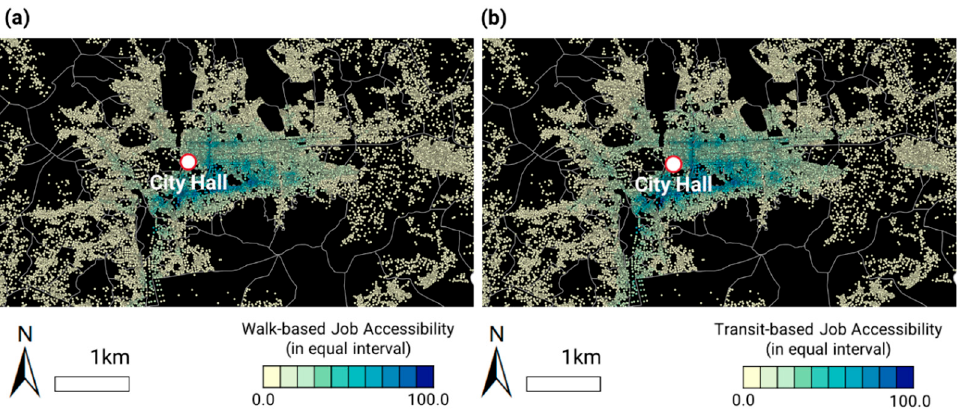
Figure 4. ( a ) Walk‑based job accessibility and ( b ) transit‑based job accessibility at the parcel level of the study area.